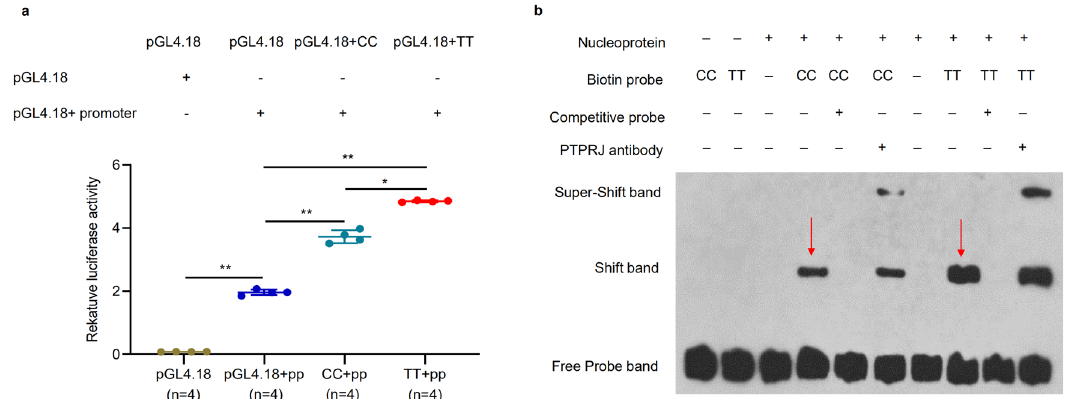
Fig. 7 Effects of causative rs736799474 on enhancer activity and binding of heterophil nuclear proteins. a Dual-luciferase reporter assay concerning the effect of the rs736799474 [T] to [C] transition on activity of a PTPRJ enhancer. Fragments containing the candidate variations were synthesized: Fragment 1 containing allele C, and Fragment 2 containing allele T. Each fragment was cloned into the 5 ’ end of a pGL4.18 vector for analysis of enhancer activity (enhancer-D). Empty pGL4.18 (Basic) was used as a negative control, and pGL4.18 containing the PTPRJ promoter ( PTPRJ Promoter) was used as a reference for enhancer activity. Data represent the mean ± SD from three biological replicates per vector. Activities of the pGL4.18 + C and pGL4.18 + T vectors were compared using Student ’ s t -test. ** indicates P < 0.01, * indicates P < 0.05. b Effects of rs736799474 alleles on binding of heterophil nuclear proteins. EMSA was performed using biotin-labeled oligo probes containing either rs736799474 allele (C) or allele (T). Two microliters of nuclear proteins (5 μ g/ μ l) from heterophils were incubated with 40 pmol of biotin-labeled probes. Speci fi c binding was con fi rmed using 200-fold excess unlabeled cold probes containing the appropriate rs736799474 allele (C cold probe or T cold probe). Arrows indicate changes in protein binding capacity between